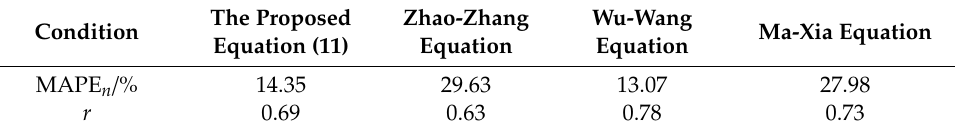
Table 3. Performance of di ff erent flow resistance equations with the Brownlie validation data.